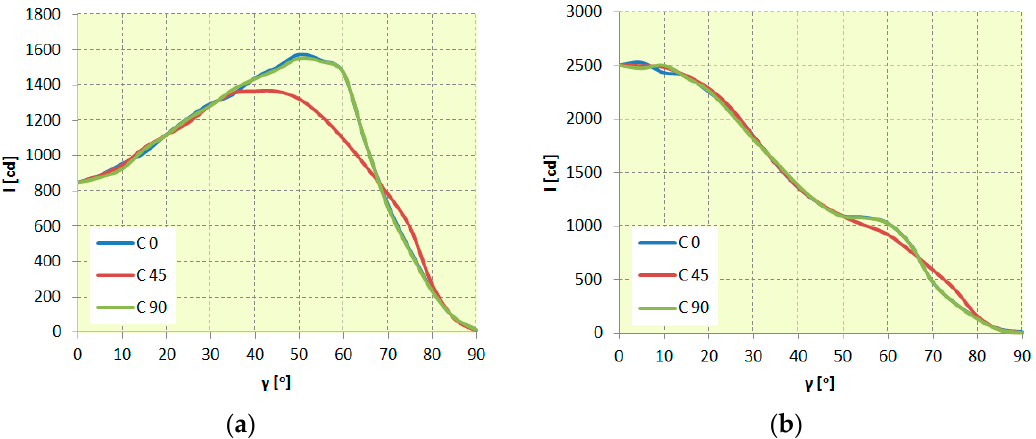
Figure 16. Luminous intensity curves for a reflector with a mirror surface and a diffusing macrostructure: ( b ) wide distribution ( b ) narrow distribution.